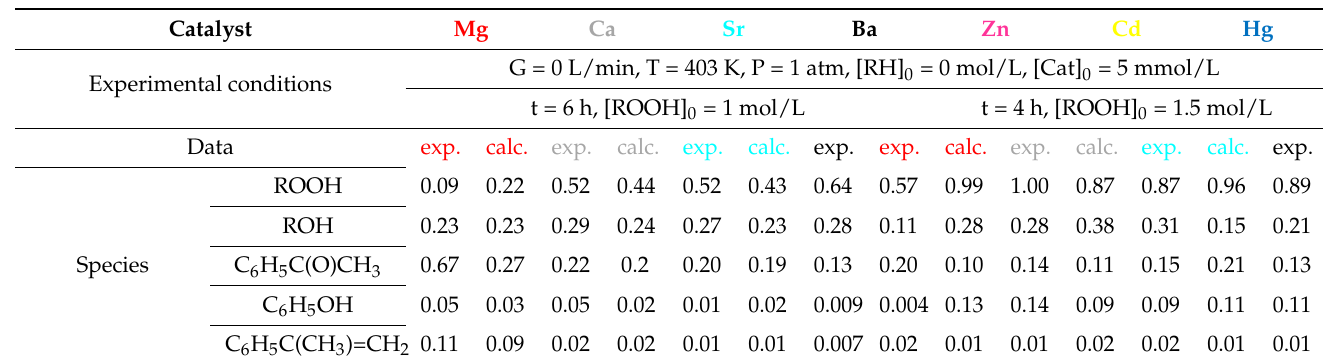
Table 4. Species concentrations (mol/L) of cumene hydroperoxide decomposition in the presence of catalyst.